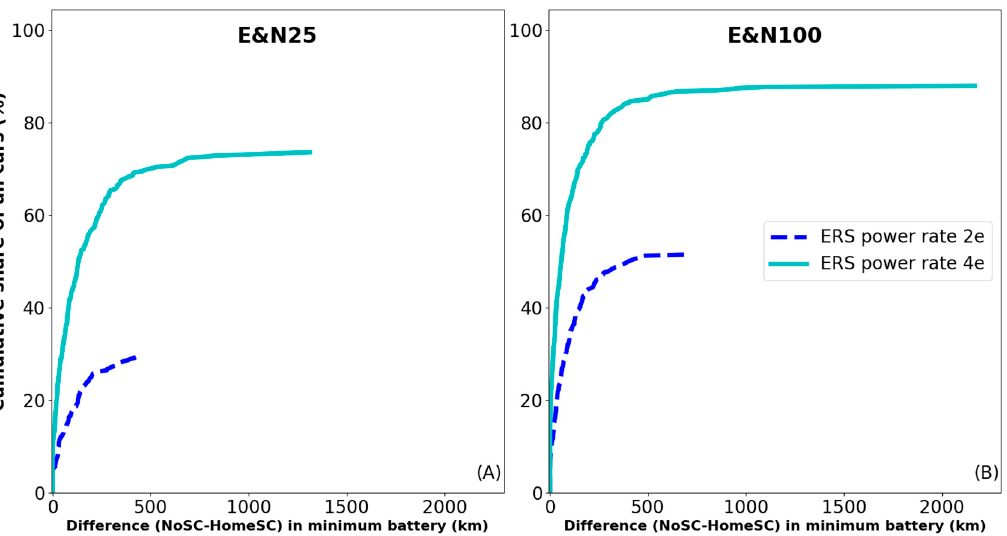
Figure 5. The cumulative share of all cars as a function of the difference in minimum battery range between ERS without and with home-only stationary charging, i.e., between NoSC and HomeSC, respectively. The share in ( A ) is shown for ERS on 25% of E and N roads (E and N25) while in ( B ) the share is for 100% of E and N roads (E and N100) for the two ERS power levels 2 e and 4 e . The cumulative shares are limited upwards by the shares of cars able to fulfill all driving without home charging (i.e., NoSC case).